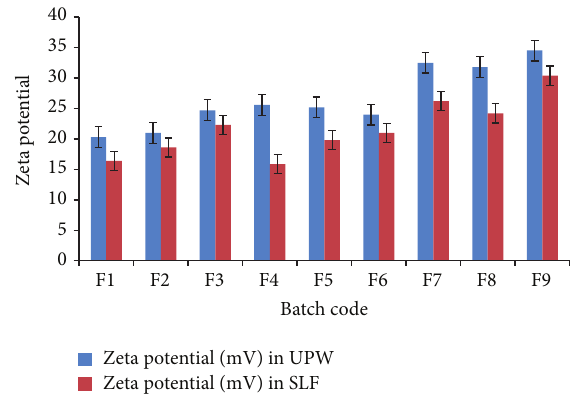
Figure 4: Zeta potential of different batches of CsA-NPs in UPW and SLF.